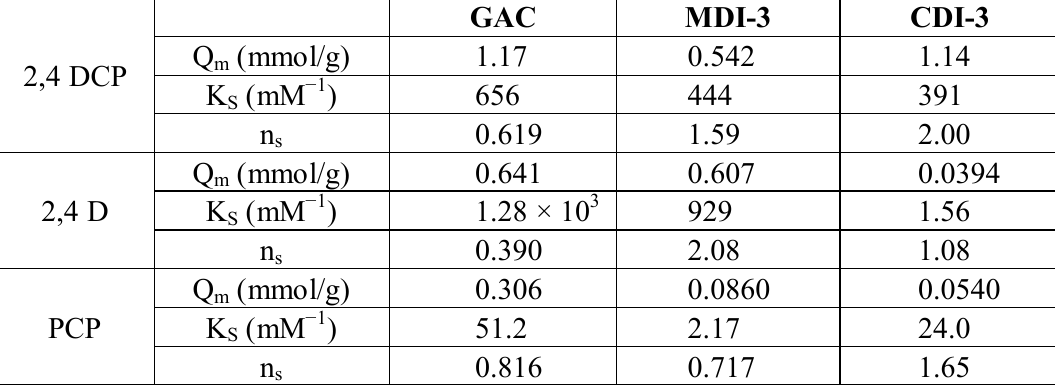
Table 1. Isotherm sorption parameters provided by the best-fit according to the Sips model at 295 K.